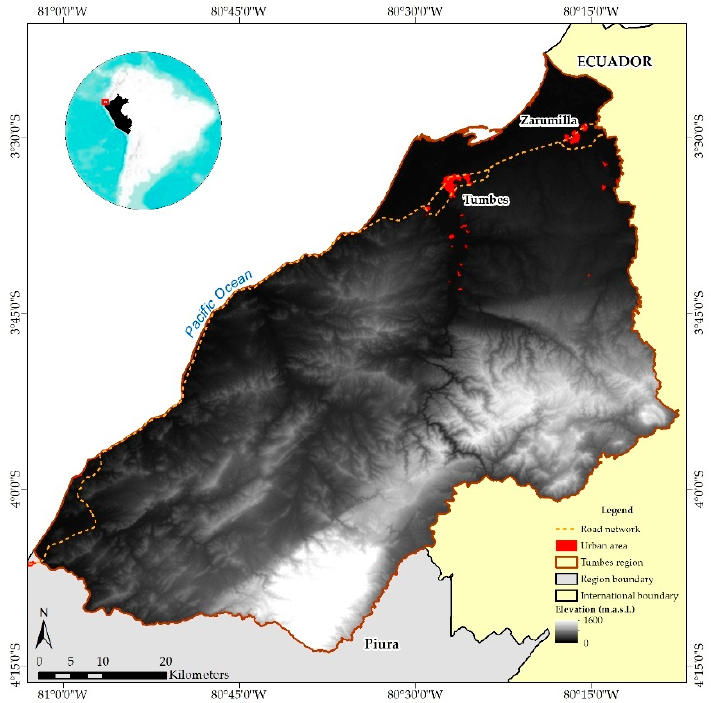
Figure 1. Location of the department of Tumbes in Peru.